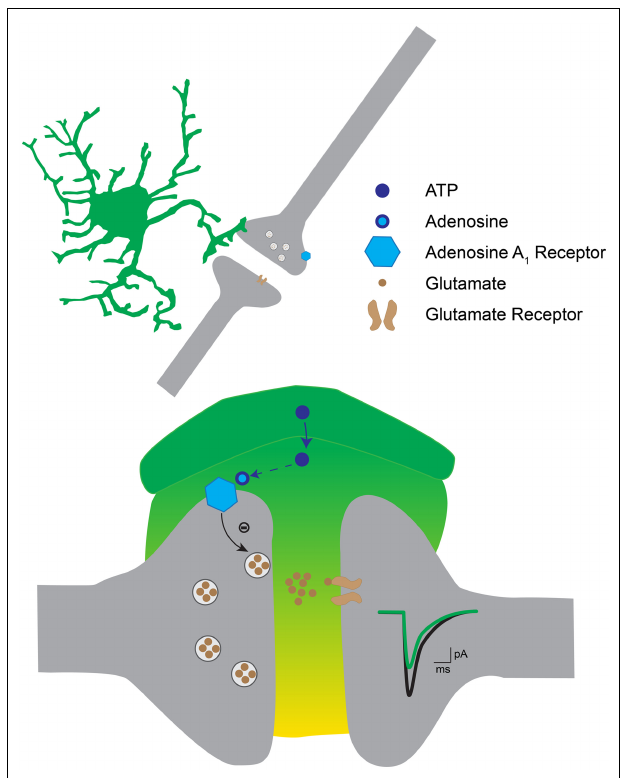
FIGURE 8 | Hypothetical mechanism for astrocytic induced presynaptic inhibition in the ventral horn. The activation of astrocytes induces the release of ATP, which gets converted into adenosine by extracellular ectonucleotidases. Adenosine binds to presynaptic A 1 receptors on excitatory terminals.This in turn decreases the probability of transmitter release. As a result excitatory postsynaptic currents are